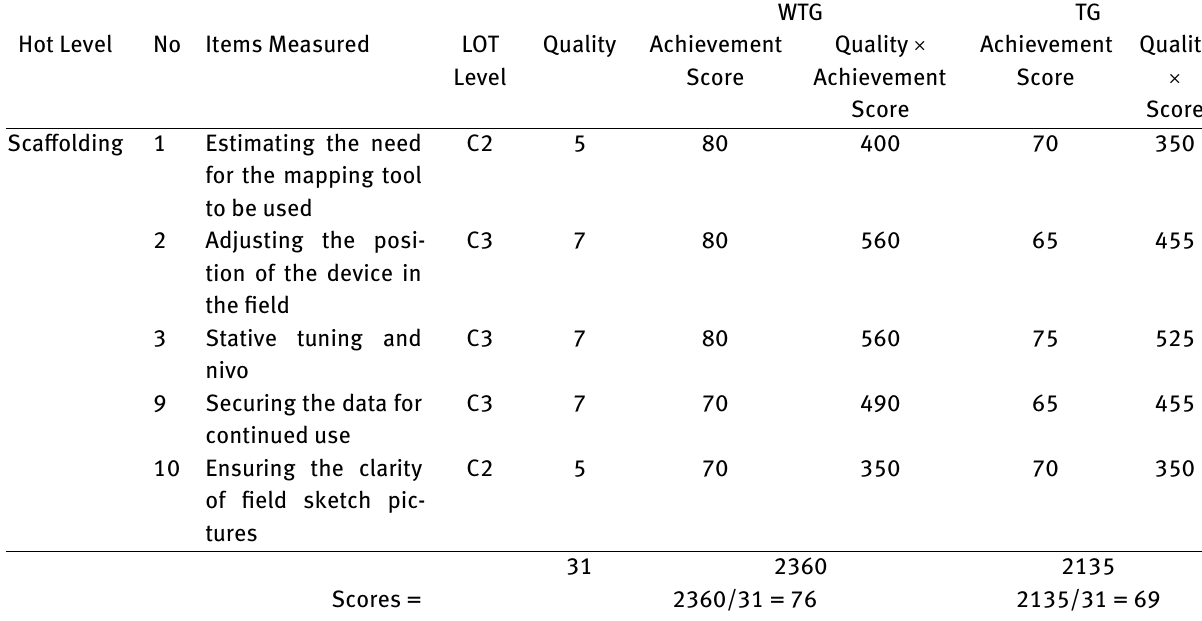
Table 2: Cognitive results to get HOTS in the first stagev Hot Level No Items Measured LOT